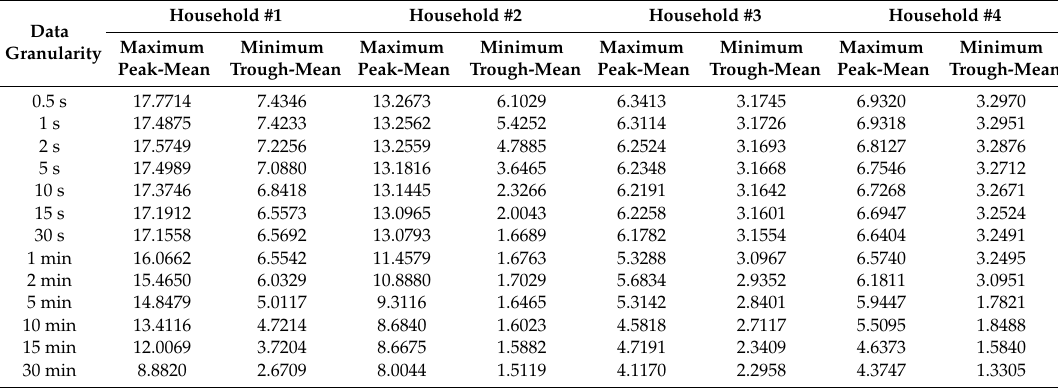
Table 4. Monthly maximum / minimum ratio of daily peak-mean load and of daily trough-mean load in January.